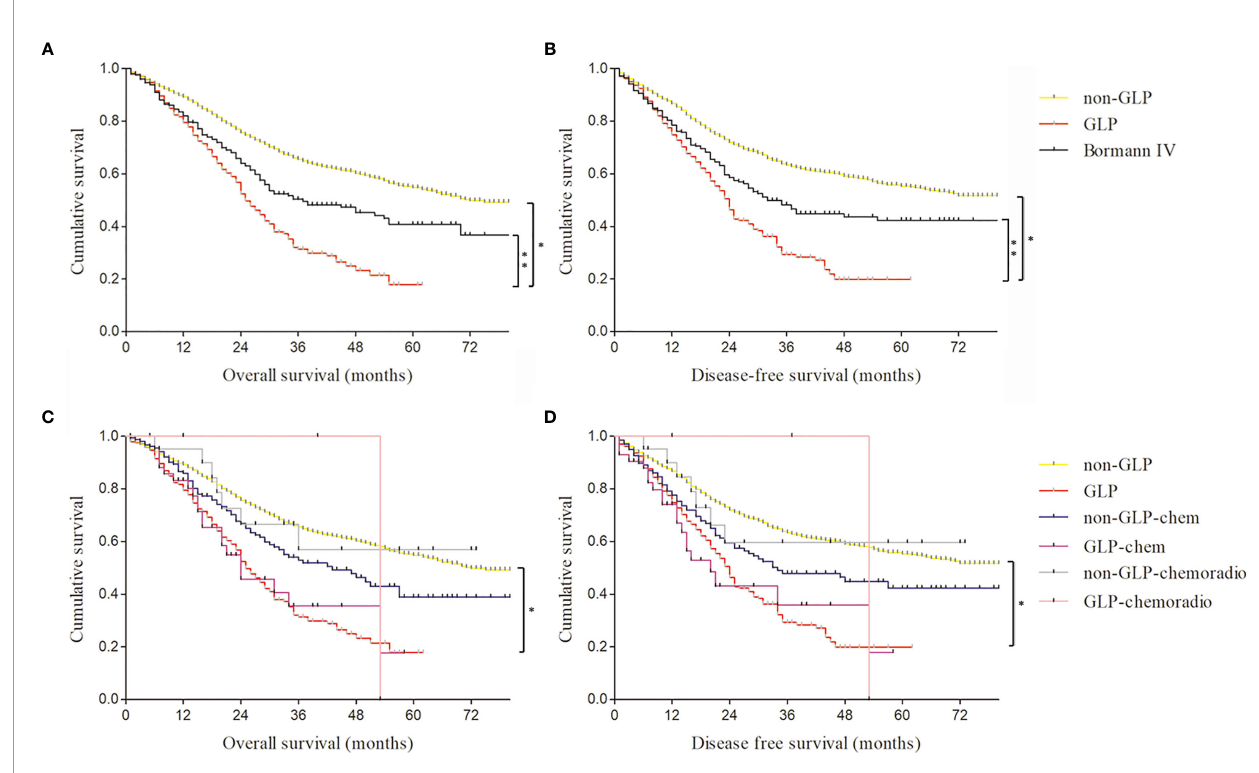
FIGURE 3 | The comparison of survival curves of gastric linitis plastica (GLP) and Borrmann IV patients with or without neoadjuvant chemotherapy and chemoradiotherapy. (A) The overall survival of GLP, non-GLP, and Borrmann IV patients in our study. *log rank p < 0.001; **log rank p = 0.015. (B) The disease-free survival of GLP, non-GLP, and Borrmann IV patients in our study. *log rank p < 0.001; **log rank p = 0.012. (C) The overall survival of GLP and non-GLP patients with or without neoadjuvant chemotherapy and chemoradiotherapy. *log rank p < 0.001. (D) The disease-free survival of GLP and non-GLP patients with or without neoadjuvant chemotherapy and chemoradiotherapy. *log rank p <